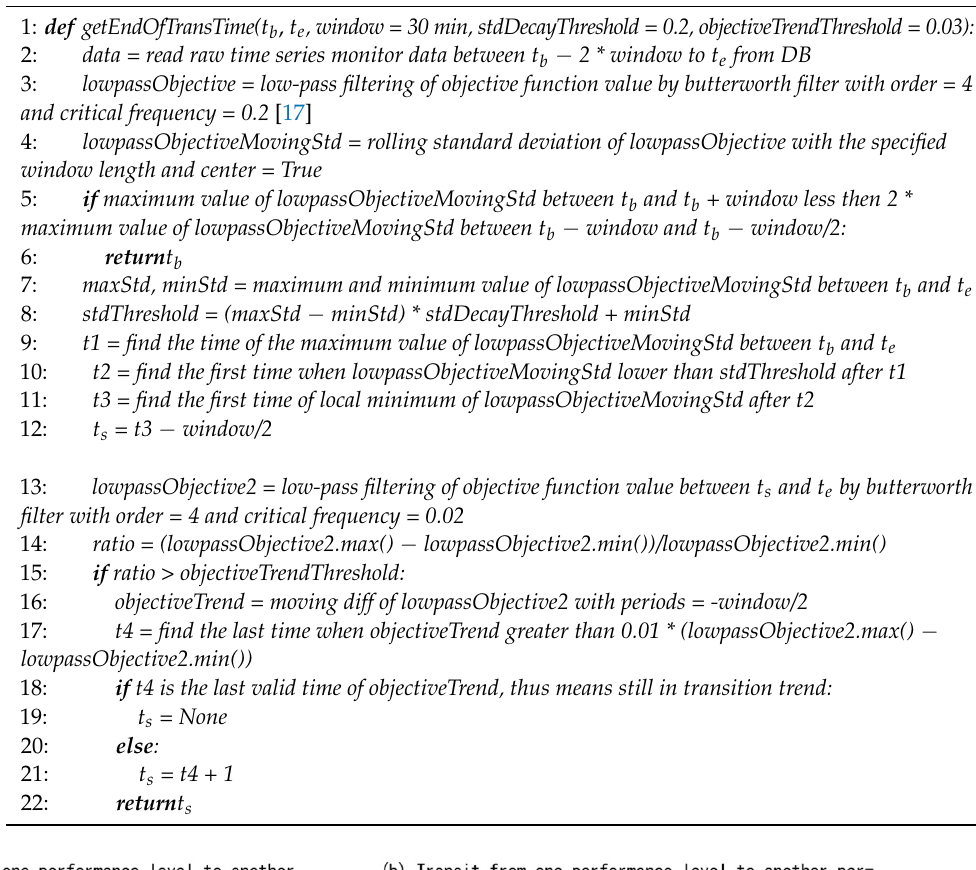
Algorithm 3: The pseudocode of the transition process identification